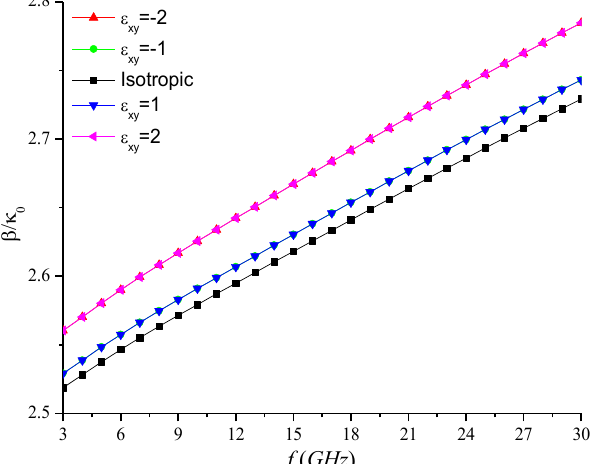
Figure 5.a: Effect of real valued e xy on the normalized phase constant